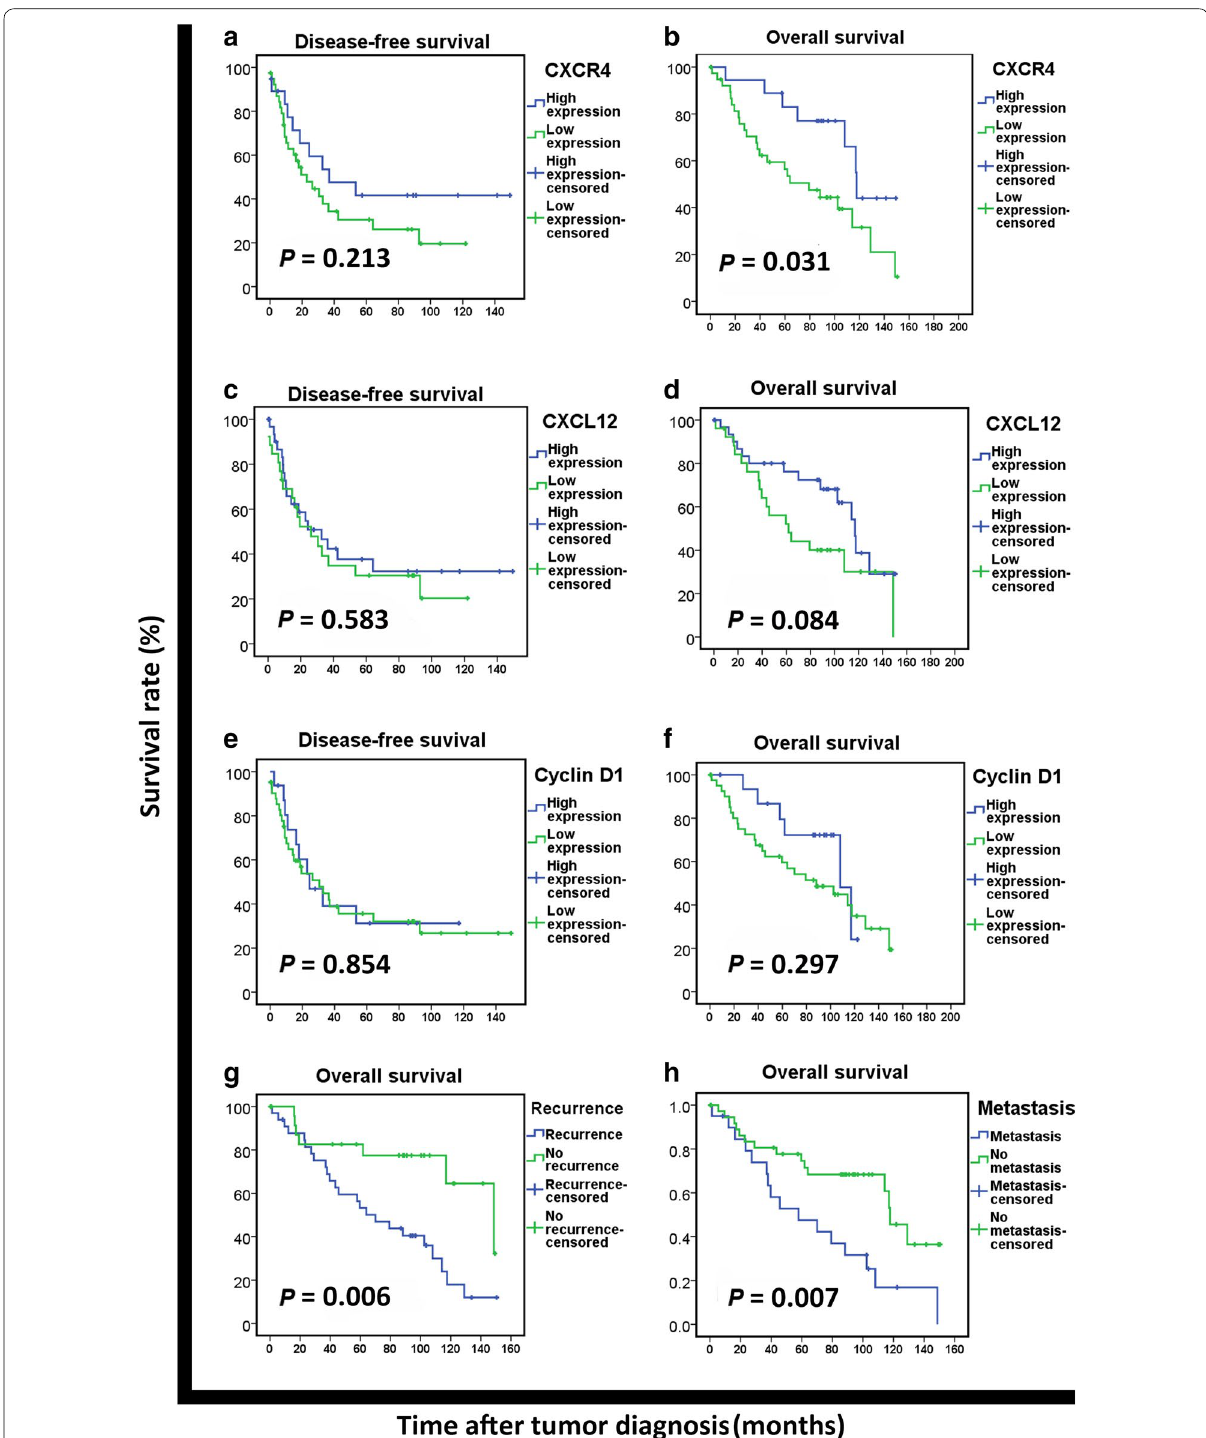
Fig. 2 Prognostic values of CXCR4, CXCL12, Cyclin D1 expression, tumor recurrence, and tumor metastasis in sporadic malignant peripheral nerve sheath tumor patients. a No association is shown between CXCR4 expression and disease‑free survival (DFS) ( P > 0.05). b Overall survival (OS) is longer for patients with high CXCR4 expression than for those with low CXCR4 expression ( P < 0.05). c No association is shown between CXCL12 expression and DFS ( P > 0.05). d No association is shown between CXCL12 expression and OS ( P > 0.05). e No association is shown between Cyclin D1 expression and DFS ( P > 0.05). f No association is shown between Cyclin D1 expression and OS ( P > 0.05). g OS is shorter for patients with recur‑ rence than for those without recurrence ( P < 0.01). h OS is shorter for patients with disease metastasis than for those without metastasis ( P <